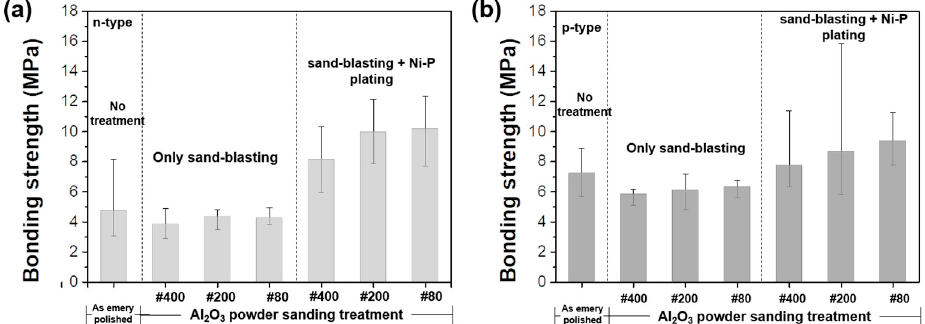
Figure 3. Effect of sand blasting and electroless Ni–P plating on bonding strength. Data for Bi–Te-based ( a ) n-type and ( b ) p-type thermoelectric elements.